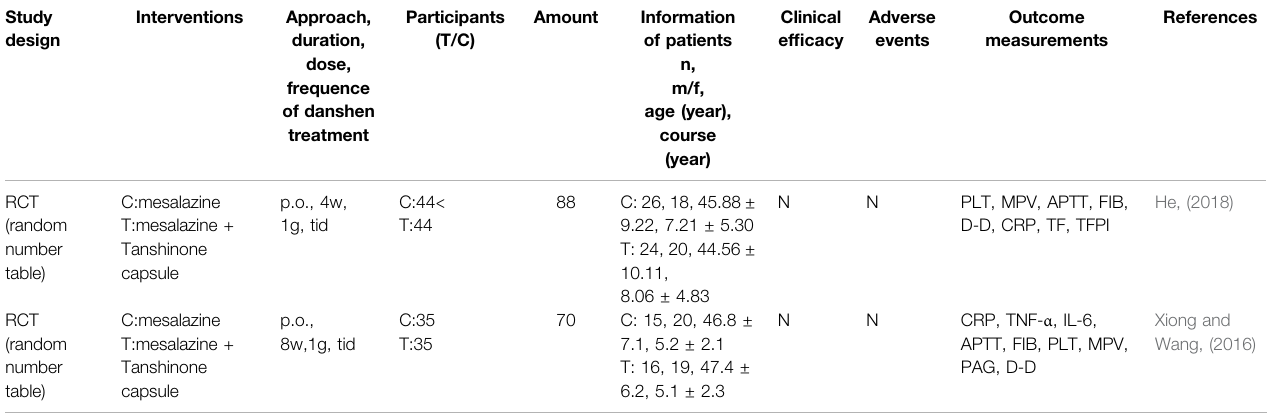
TABLE 4 | Clinical trials of Danshen products as supplementary interference in the regulation of ulcerative colitis (UC) (Lipophilic cluster). Study